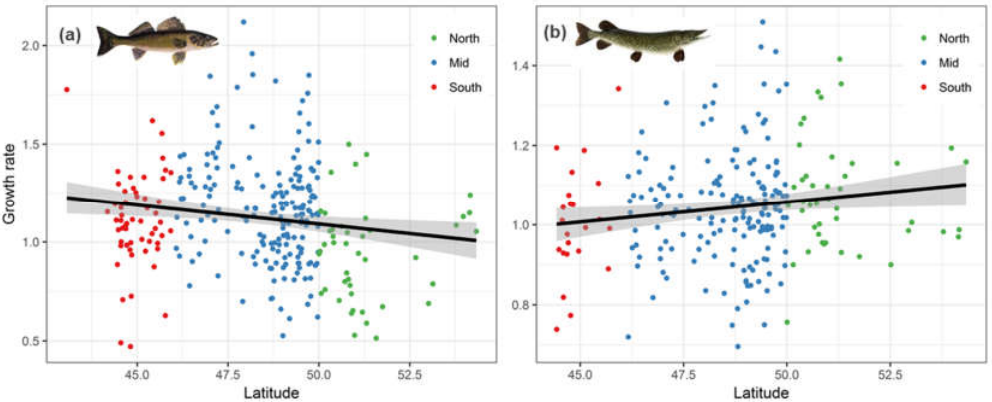
Figure 4. Latitudinal variation in growth rate of ( a ) Walleye (R 2 = 0.065; p -value = 0.0012) and ( b ) Northern Pike (R 2 = 0.015; p -value = 0.051) expressed as random slopes of LMEMs of fish growth model (Equation (2) in text) with each unique waterbody as the random effect. Shaded area indicates 95% confidence interval. (Note: y -axis scale differs between a and b).